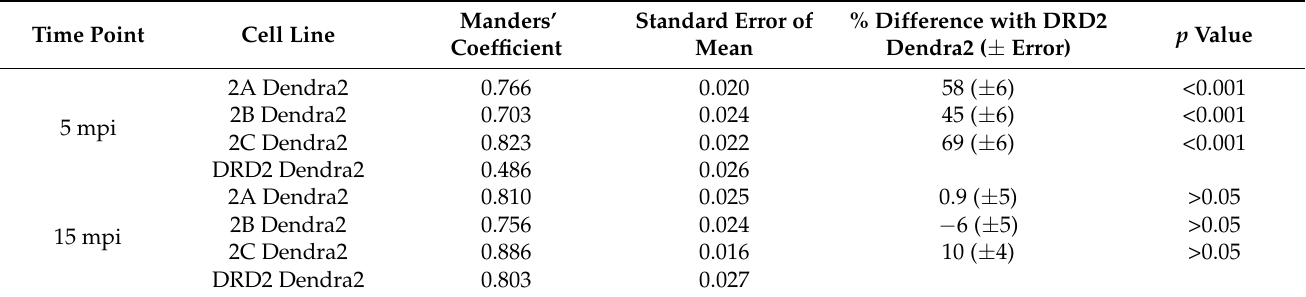
Table 1. Summary of JCPyV-647 Manders’ colocalization coefficient with all 5-HT 2 R subtypes in comparison to DRD2 sample at 5 mpi and 15 mpi. JCPyV-Alexa647 colocalization with all subtypes of